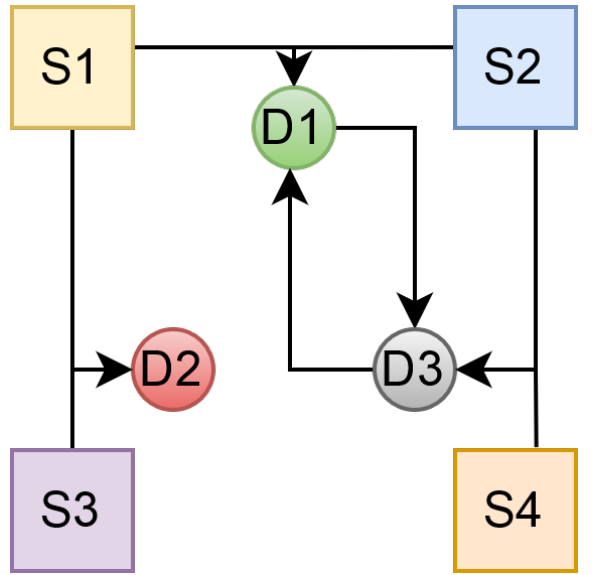
Figure 1. An example of a collective built from deductive